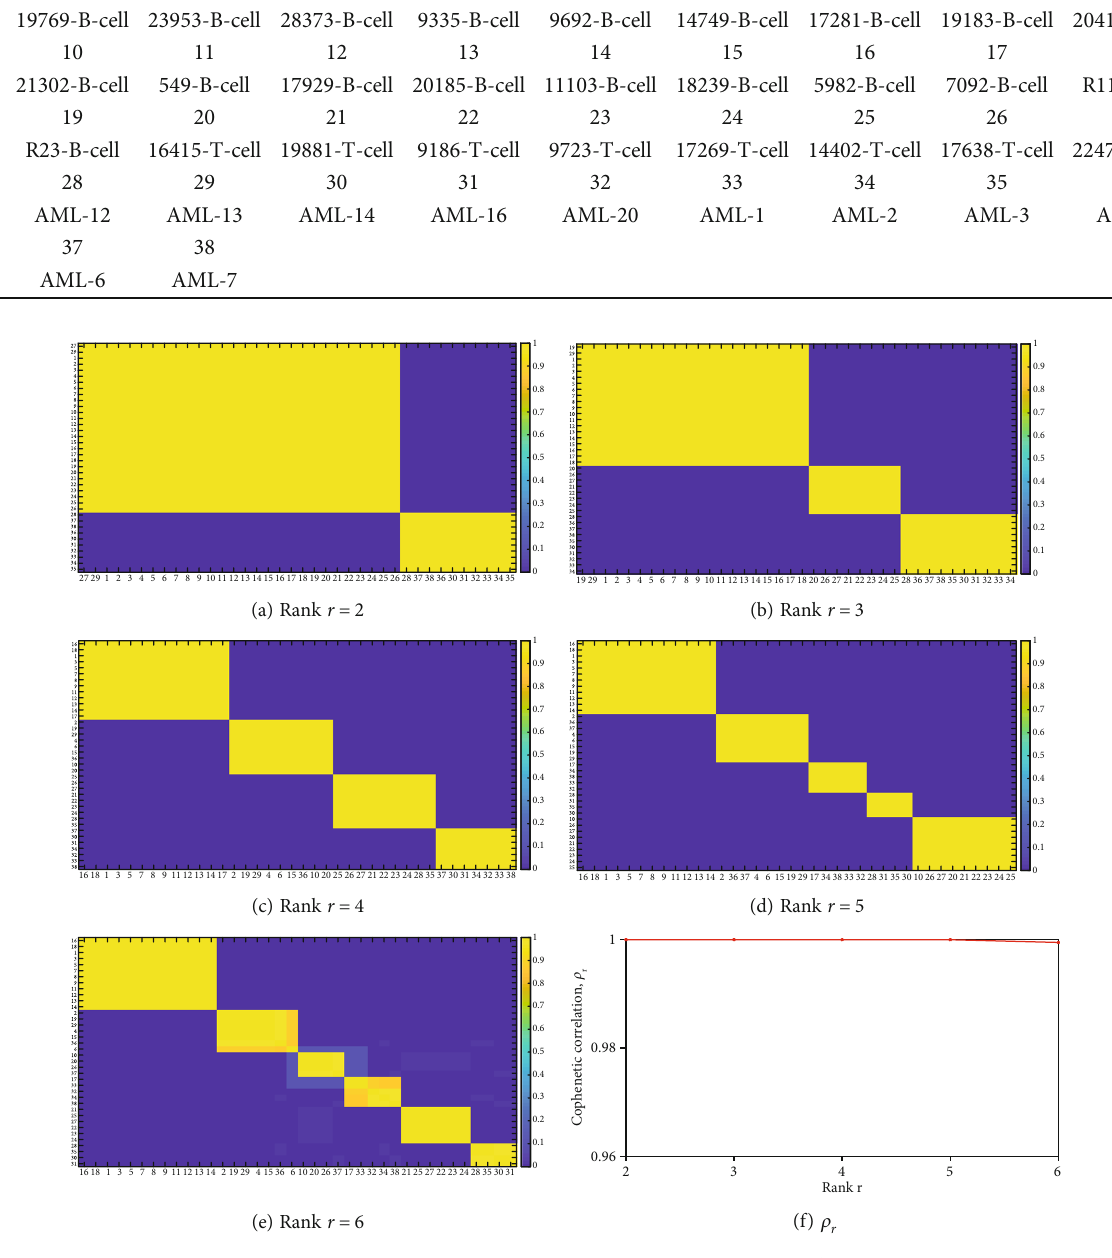
r = 2 ‐ 6 using ALL-AML. r for